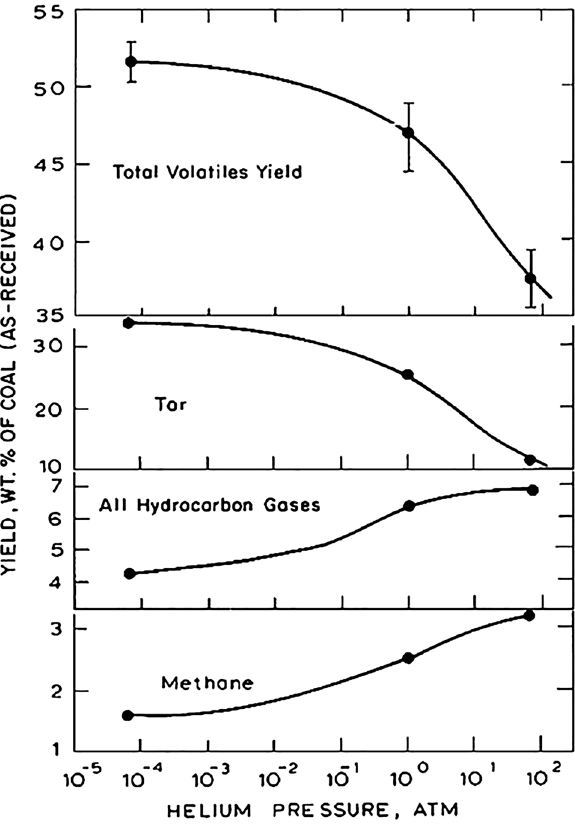
Fig. 7 The yields of volatile species vs. pressure during the pyrolysis of Pittsburgh No. 8 coal at 1270 K, Yu et al. (2007)